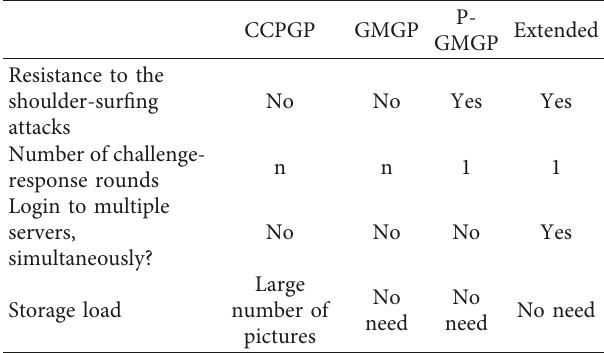
Table 1: The comparison among different graphical password